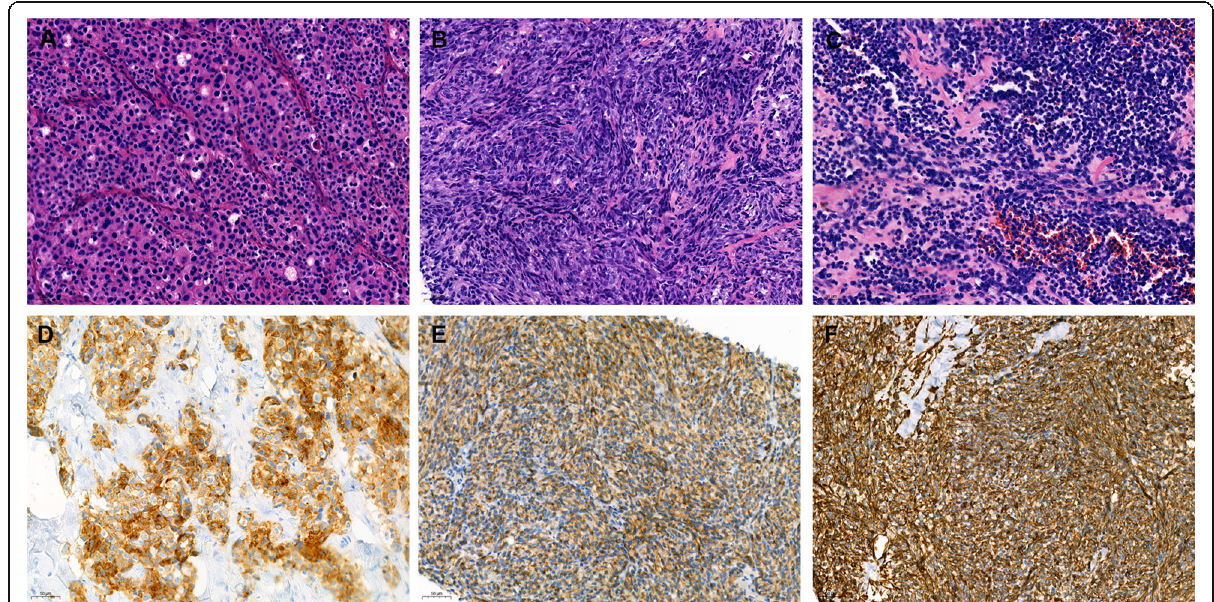
Fig. 1 Representative images of H&E staining ( A - C ) and immunohistochemical staining ( D - F ) in melanomas. A epithelioid subtype, B spindle cell subtype, C small round cell type, D Syn, E CD56, F Vimentin (magnification: